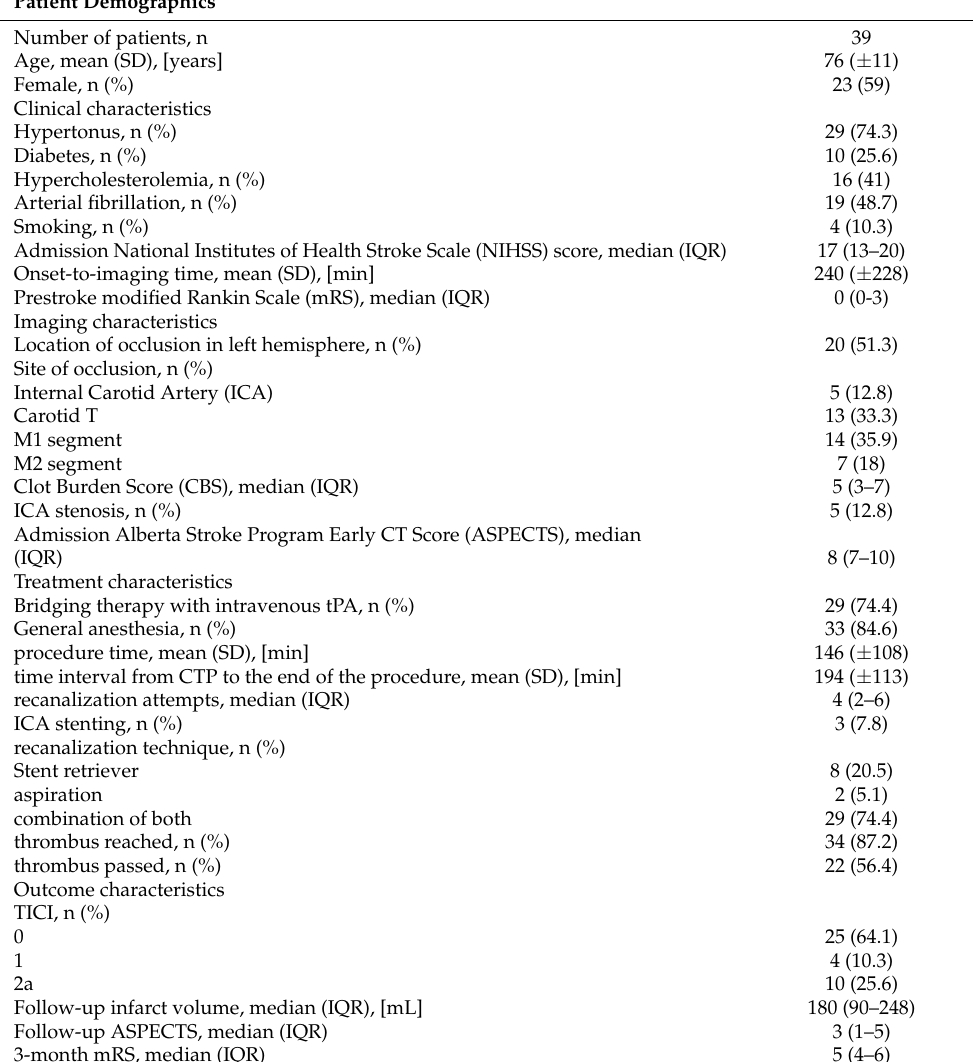
Table 1. Patient characteristics, clinical parameters, and outcome